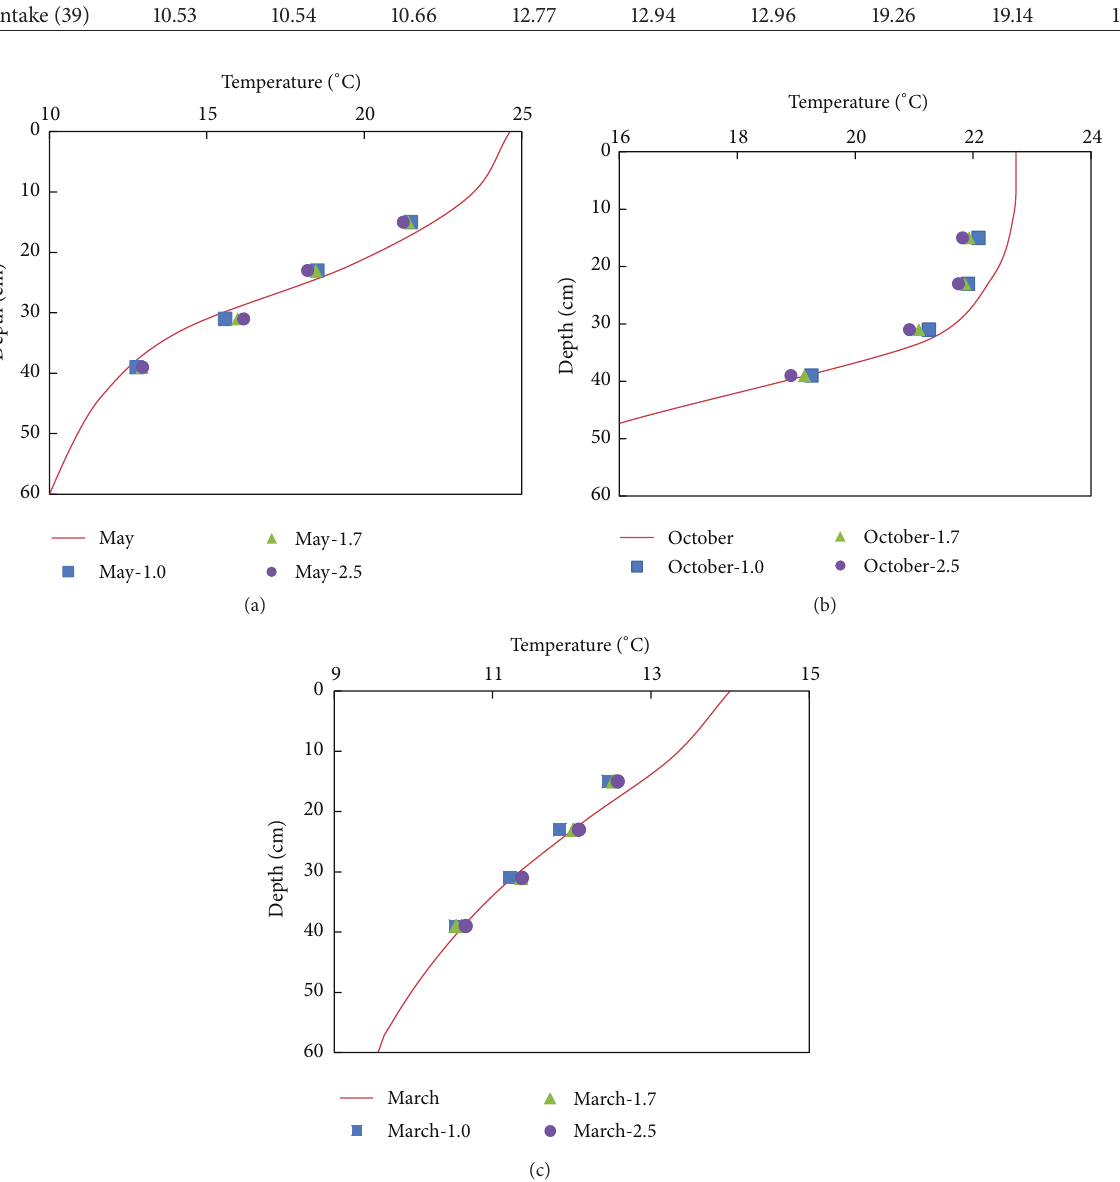
rate changed from 1.0 L/s to 2.5 L/s, whereas the temperature of the fourth intake increased from 12.77 ∘ C to 12.96 ∘ C at the same situation. In terms of the four experiments in October, the temperature of withdrawn water decreased when the flow rate increased. The change amplitude was between 0.15 ∘ C and 0.35 ∘